Question: Provide a one-line summary of what is displayed.
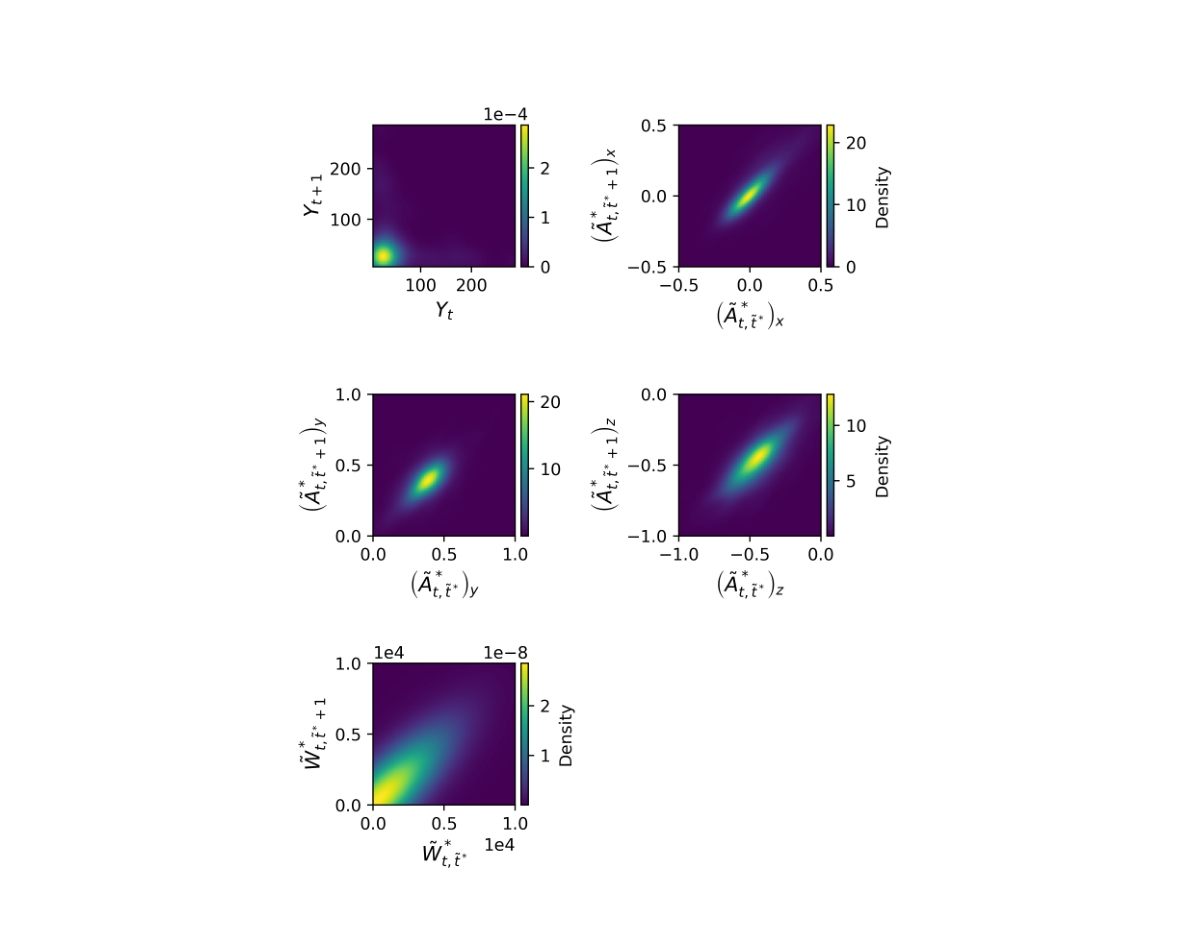
Answer: Collection of 5 lag plots where a given observation is on the x-axis and the subsequent observation is on the y-axis. Each plot corresponds to a feature in the killer whale dive data. Lag plots are used to decide whether to include auto-correlation in the HMMs used to model the killer whale’s kinematic data. They can also be used to determine the number of hidden states if multiple distinct patterns are visible.